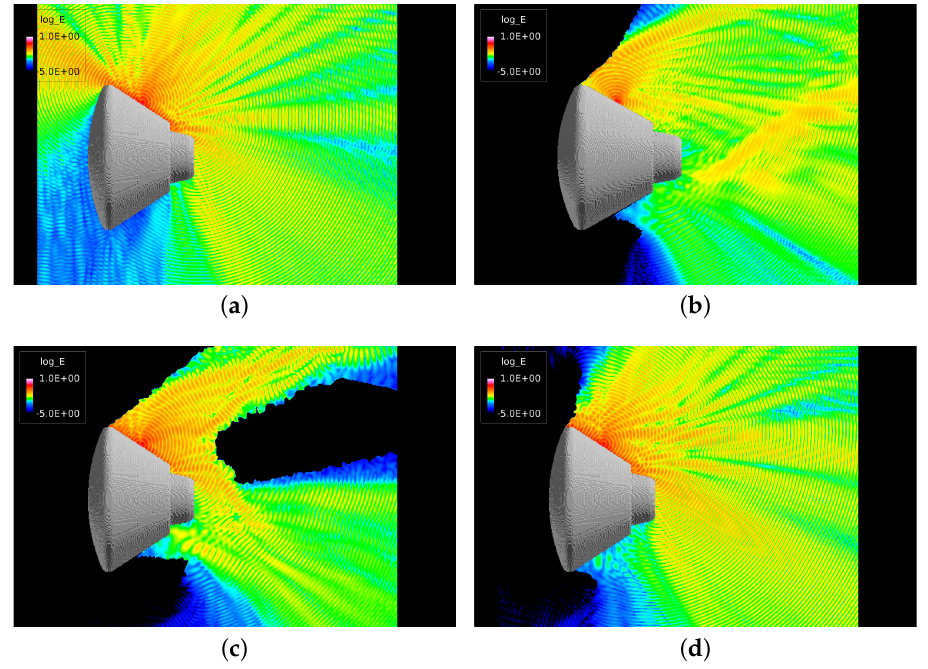
Figure 13. Electromagnetic waves (magnitude of electric field) around the ESA ARD at an elapsed time of 3.75 × 10 − 8 s. ( a ) Results for free space ( x – y plane); ( b ) results at an altitude of 85 km ( x – y plane); ( c ) results at an altitude of 60 km ( x – y plane; ( d ) results at an altitude of 50 km ( x – y